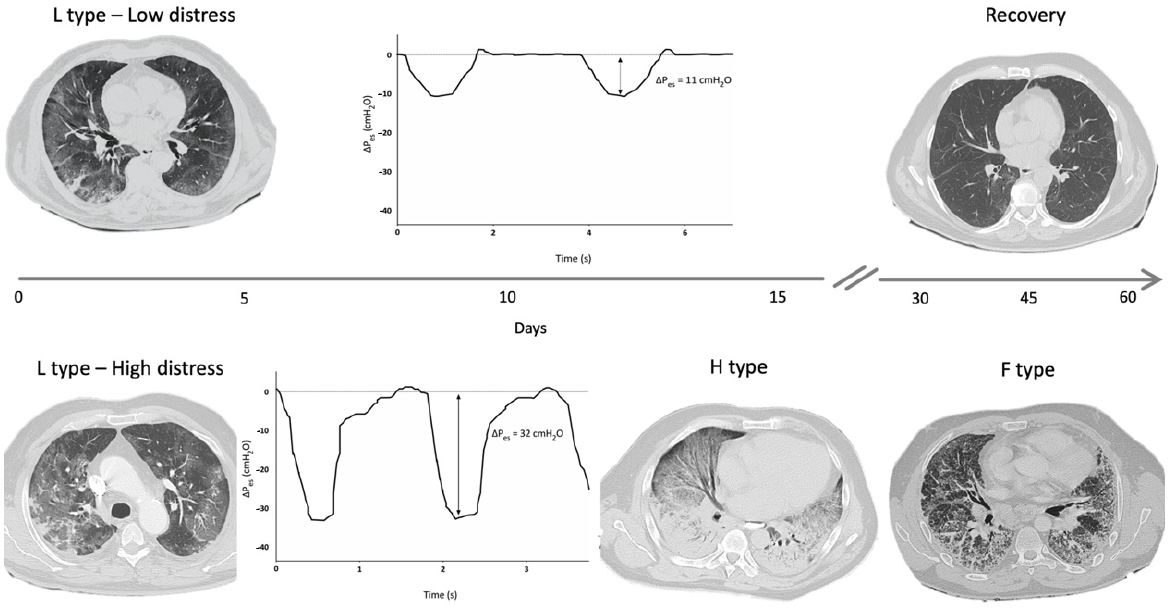
Figure 2. Hypothetical role of inspiratory effort in progression from type L to type H and F: Figure 2 shows DPes monitoring in two patients with SARS-CoV-2 pneumonia undergoing non-invasive ventilation (NIV) with Helmet. Patient 1, at the top of the figure, shows type L phenotype on computed tomography (CT) scan, and modest inspiratory effort (DPes 11 cm H 2 O). Over time, a progressive clinical and radiological improvement with ground glass changes resolutions was recorded. Patient 2, at the bottom of the figure, shows significant inspiratory effort (DPes 32 cm H 2 O). Over time, there was a progression from type L to type H required intubation and invasive mechanical ventilation. Progression from type H to type F was documented after 45 days from Intensive Care Unit admission. DPes: Change in esophageal pressure.